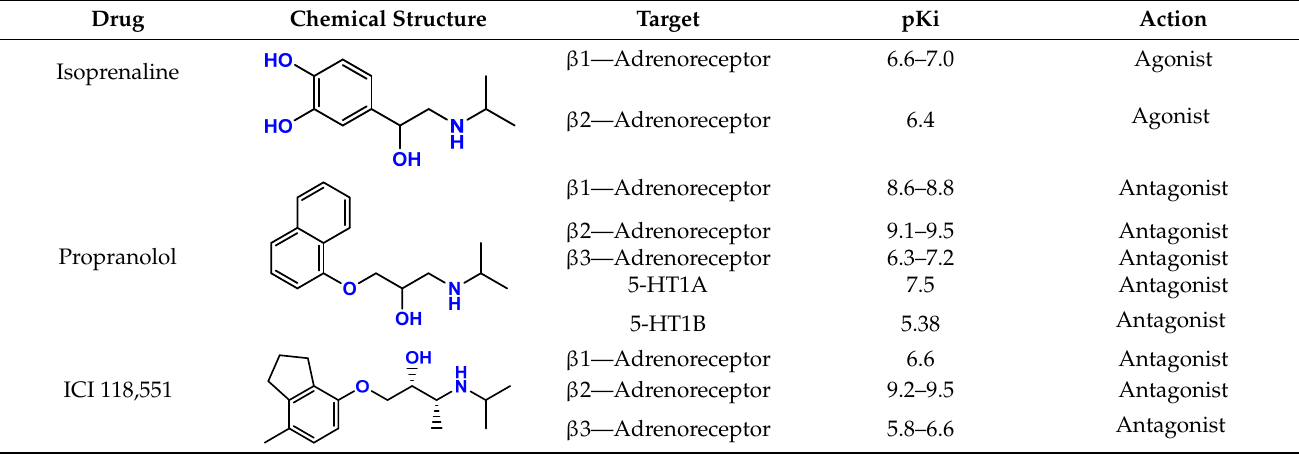
Table 1. Known targets of isoprenaline, propranolol, ICI 118,551, and respective chemical structure, action/pKi values on these targets. Data from [18–20].